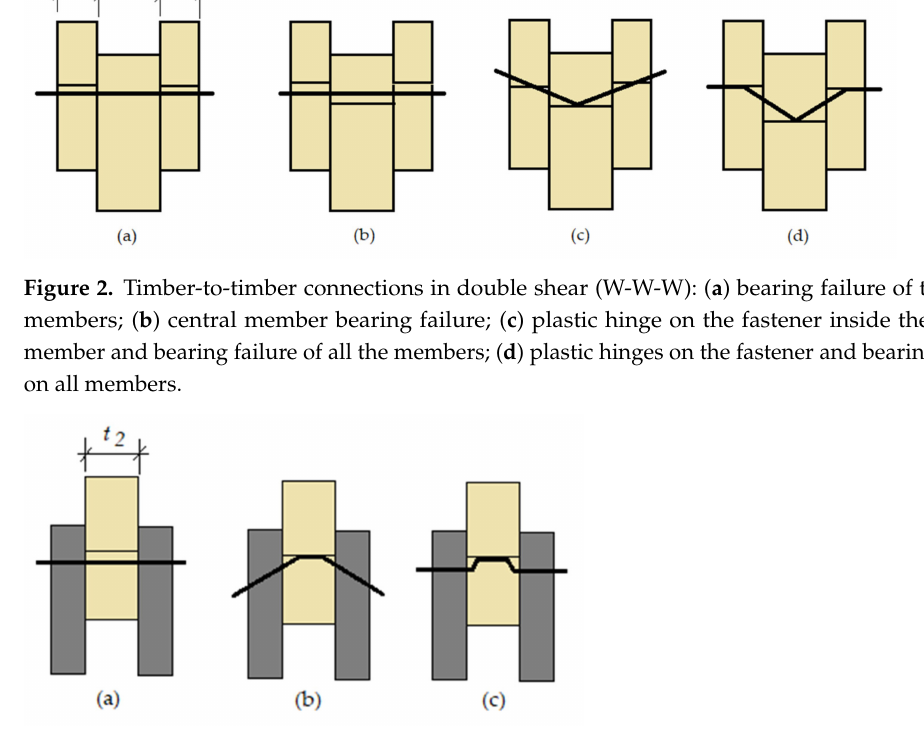
Figure 3. Steel-to-timber connections in double shear (S-W-S): ( a ) wood embedding; ( b ) fastener bending; ( c ) combination of failure